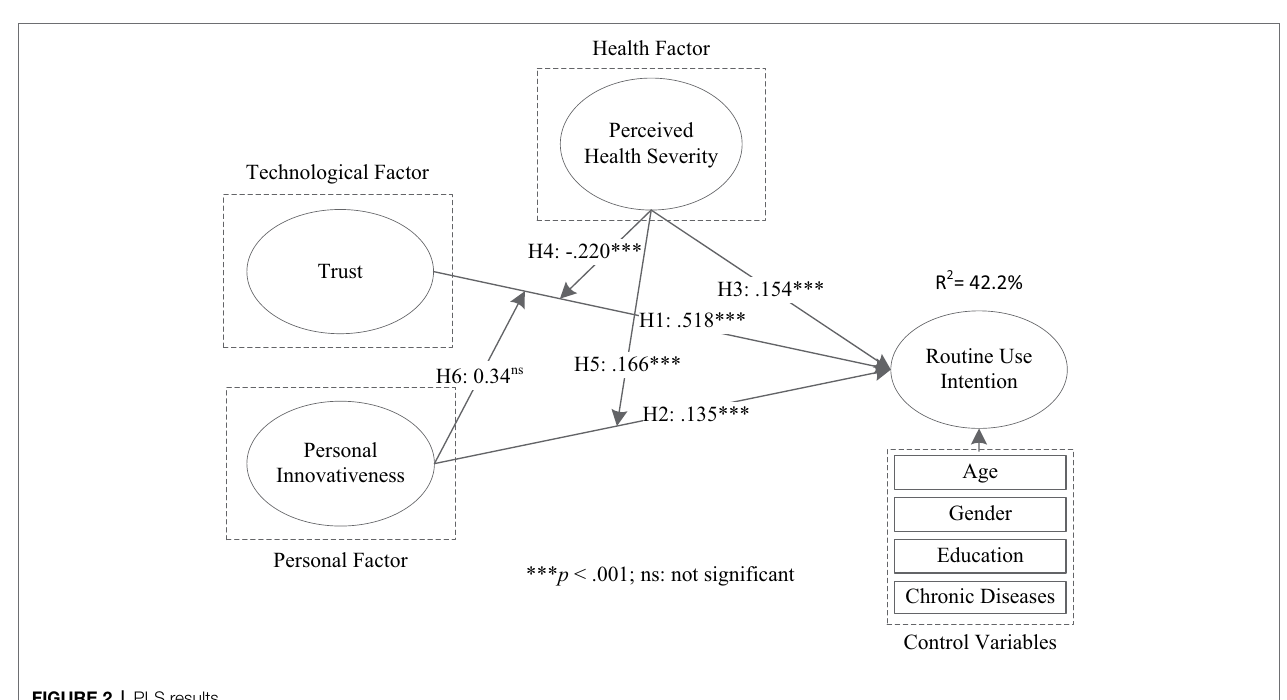
FIGURE 2 | PLS results.